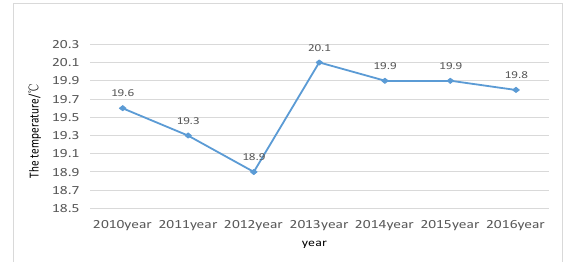
Figure 4-4 annual average temperature changes in Guilin from 2010 to 2016 According to the average temperature value in the table, the